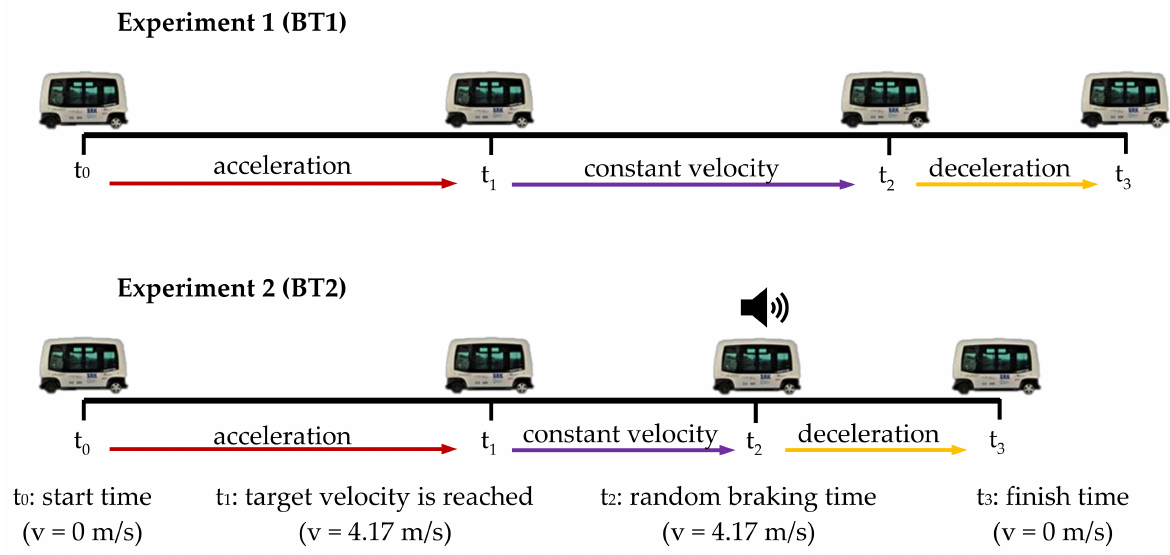
Figure 3. Timing of BT1 and BT2 experiments. Based on